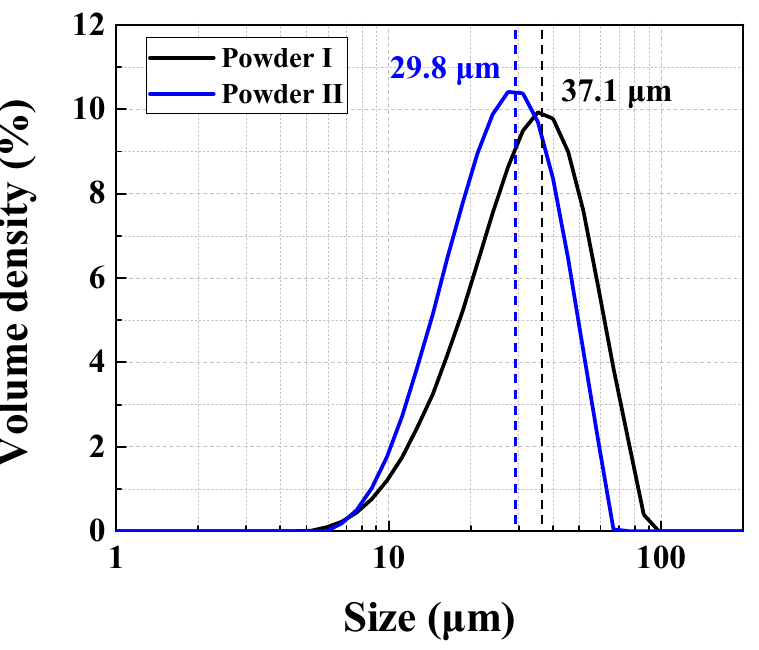
Figure 3. Particle size distribution of FS GH3536 (Powder I) and nickel alloy HX (Powder II).